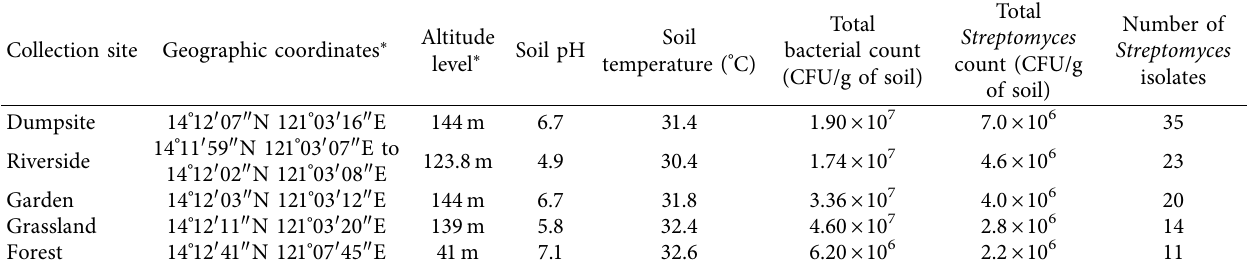
Table 1: Location and environmental characteristics of the collection site with corresponding bacterial load from each soil sample. Collection site Geographic coordinates ∗